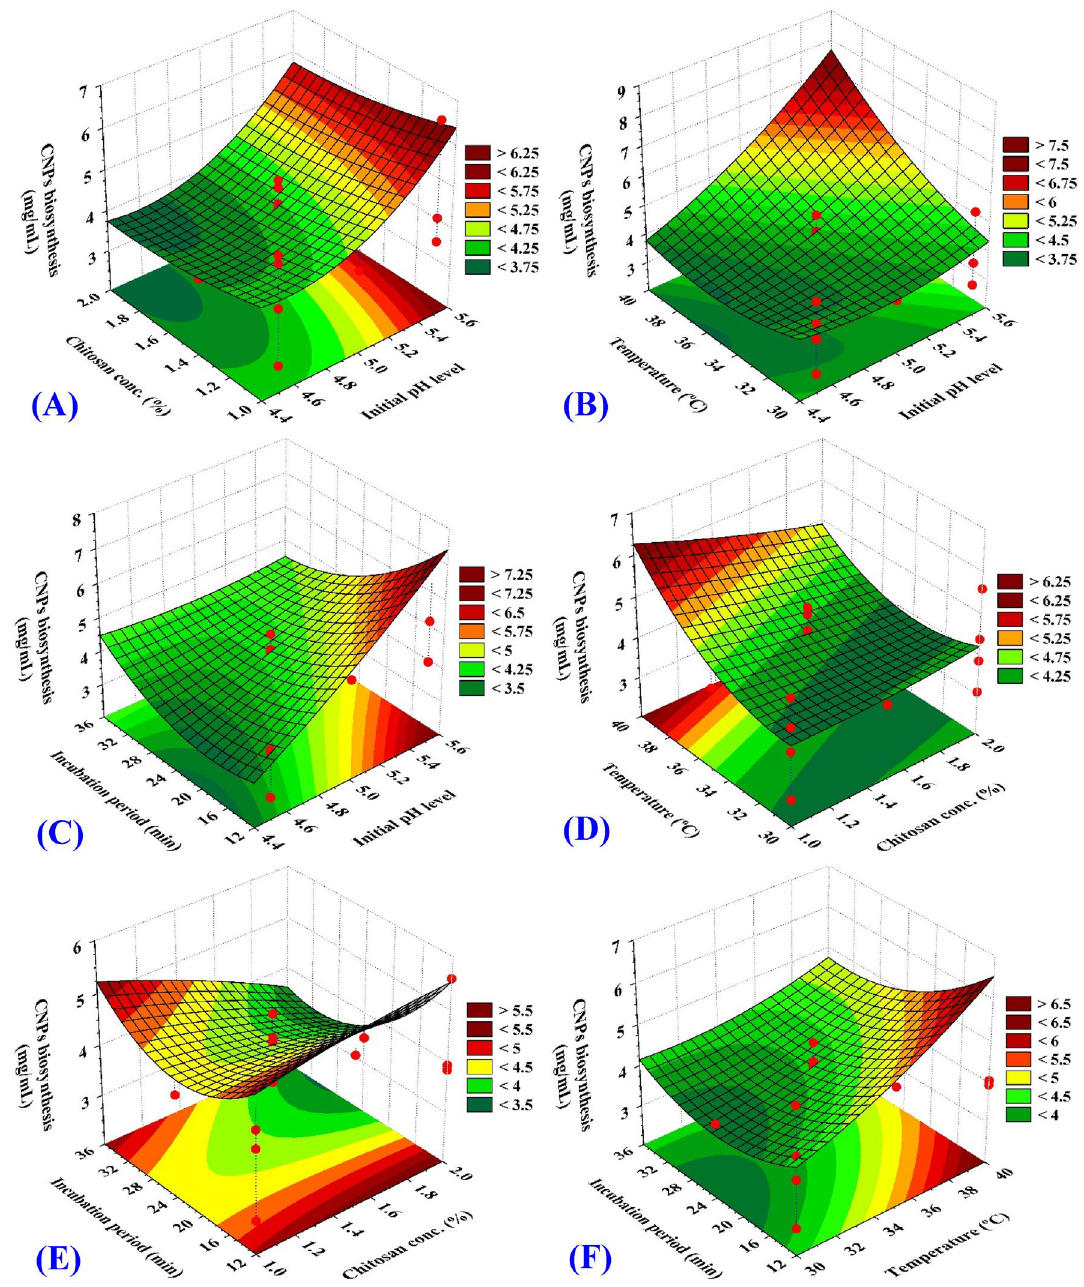
Figure 11. Three-dimensional surface plot of the interactive impact of each pair of factors for chitosan nanoparticles biosynthesis by Streptomyces microflavus strain NEAE-83. The other factors were kept at the center